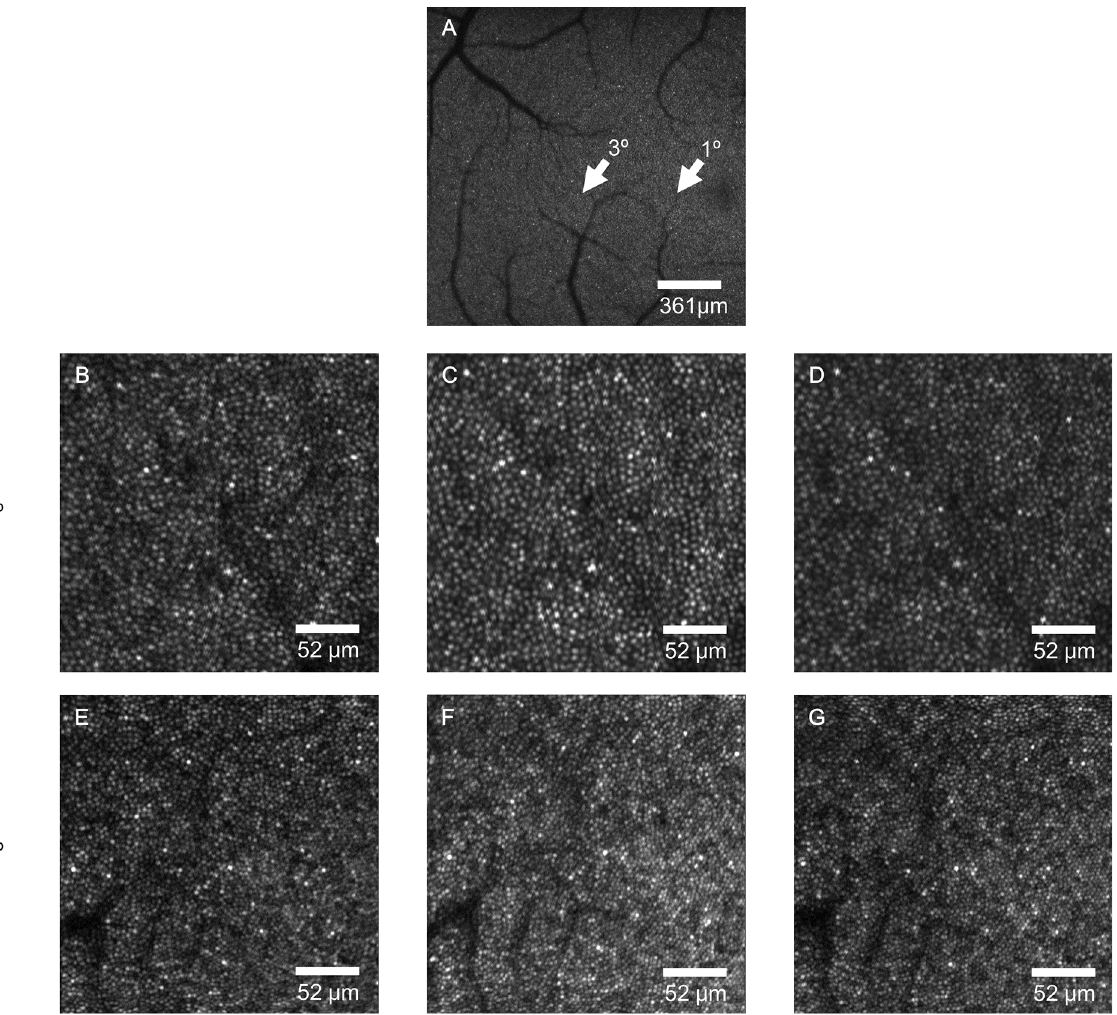
Fig 1. Images of photoreceptors in the right eye of subject 2 taken by AO-SLO. A: The AO-SLO image with low magnification (7° * 7°) with a center 3° temporal from the fovea. B-D: The AO-SLO image with high magnification (1° * 1°) at 3° temporal from the fovea as indicated in A. E-G: The AO-SLO image with high magnification (1° * 1°) at 1° temporal from the fovea as indicated in A. B and E: Images taken before light stimulation. C and F: Images taken during light stimulation (72-s after the onset of light stimulation). D and G: Images taken 60-s after the cessation of light stimulation.